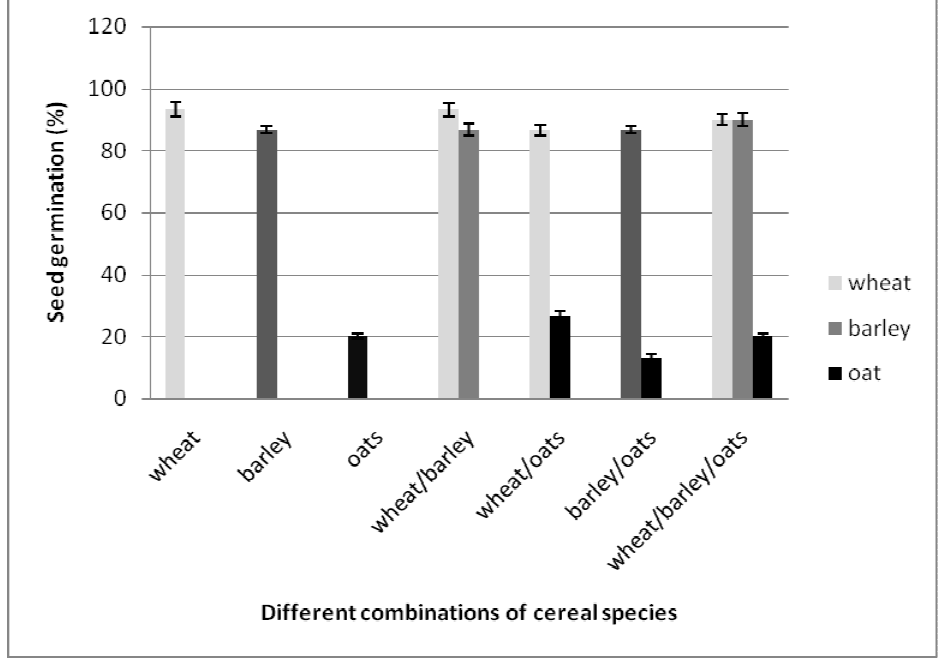
Figure 1. Allelopathic effect between selected cereals on seed